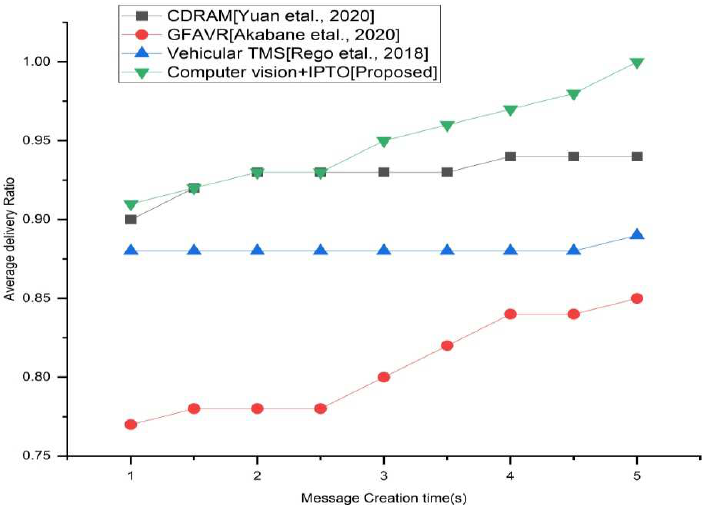
Figure 3. Average delivery ratio vs. different message interval for the existing and proposed method.